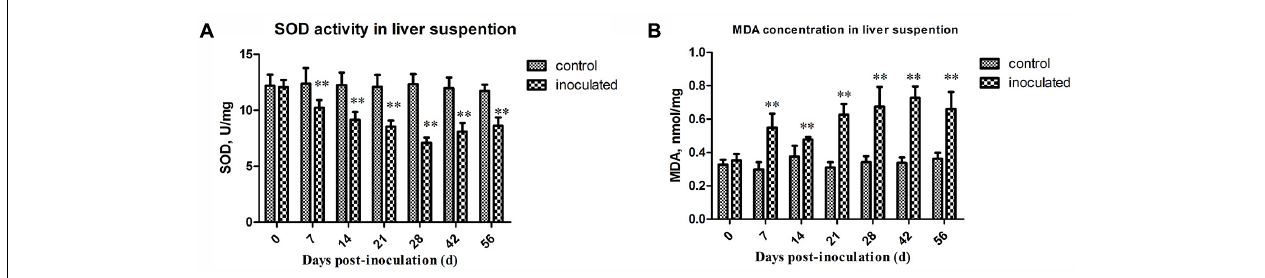
FIGURE 2 | Changes in activity of SOD and concentration of MDA. (A) The activity of SOD decreased significantly in inoculated group compared to that of the control group ( p < 0.01) at 7, 14, 21, 28, 42, and 56 dpi. And at 28 dpi, the activity of SOD was at the lowest level, 7.08 ± 0.89 U/mg. (B) MDA concentration significantly increased in livers of inoculated group after HEV infection than the control group ( p < 0.01). And the concentration of MDA was at the peak at 42 dpi, 0.73 ± 0.07 nmol/mg. ∗ p < 0.05, ∗∗ p <